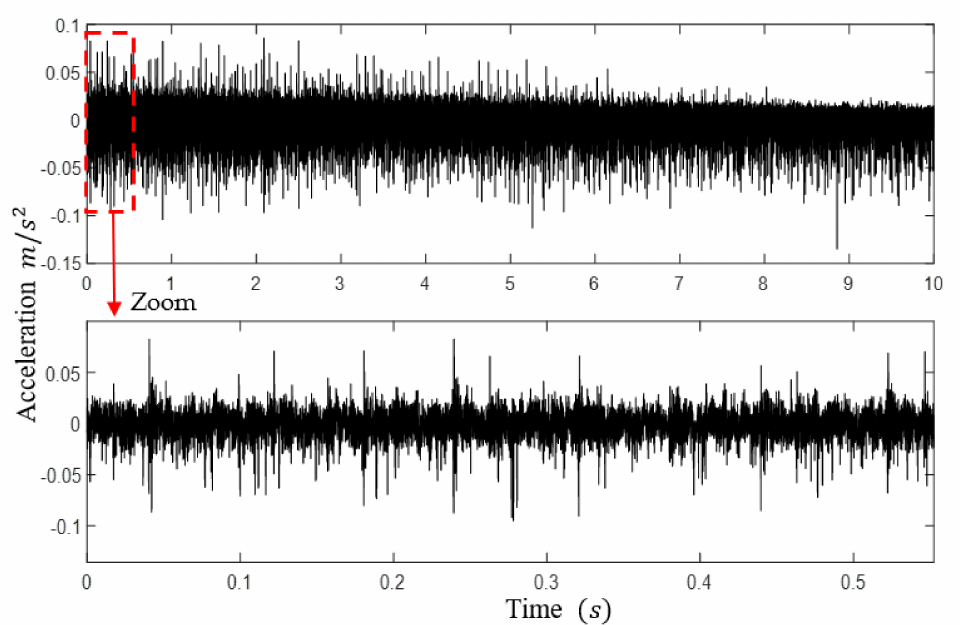
Figure 3. Raw vibration signal of a faulty bearing with an outer race defect, (Rotation speed decreas- ing from 25.4 Hz to 10.3